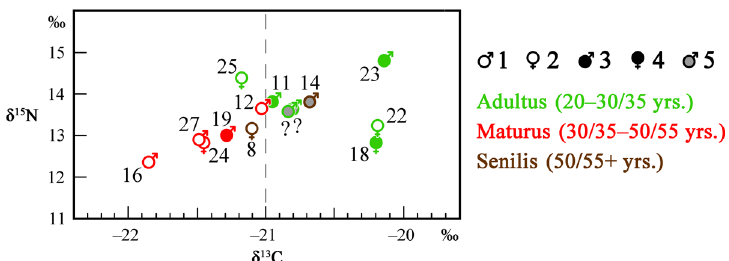
Figure 8: Vasylivka II. Scatterplot of δ 15 N and δ 13 C isotope values of human bones from Vasylivka II cemetery, taking into account age and gender of the individuals ( according to data from Lillie & Jacobs, 2006, p. 881, Table 1 ) , as well as their craniology and burial numbers ( after Gokhman, 1966 ) . Illustration by D. Haskevych. Legend: 1 – meso - brachycephalic male; 2 – meso - brachycephalic female; 3 – dolichocephalic male; 4 – dolichocephalic female; 5 – male ( craniological type